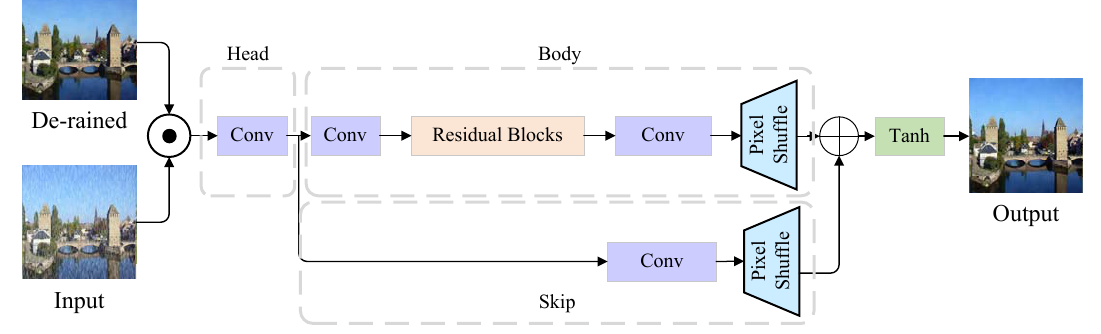
Figure 6. The architecture of Refine Network. It consists of head, body and skip